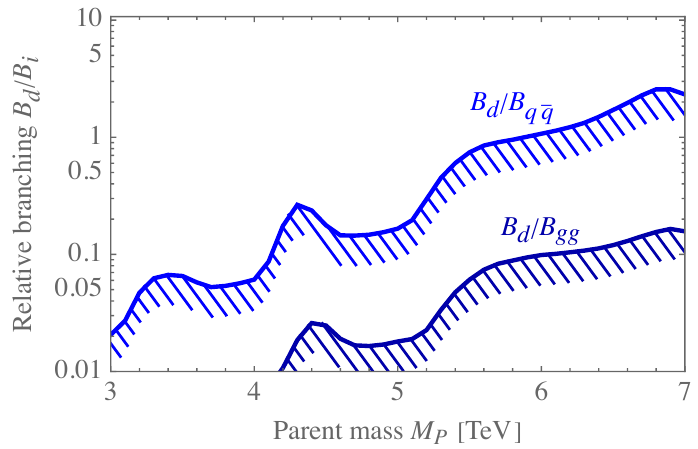
Figure 4 . Lower bounds on the relative branching B d /B i , both for the gluon ( i = qq ) and quark ( i = q ¯ q ) production channels, obtained from the CMS limits on dijet searches [19]. Other parameters have been fixed to reproduce the ATLAS dE/dx